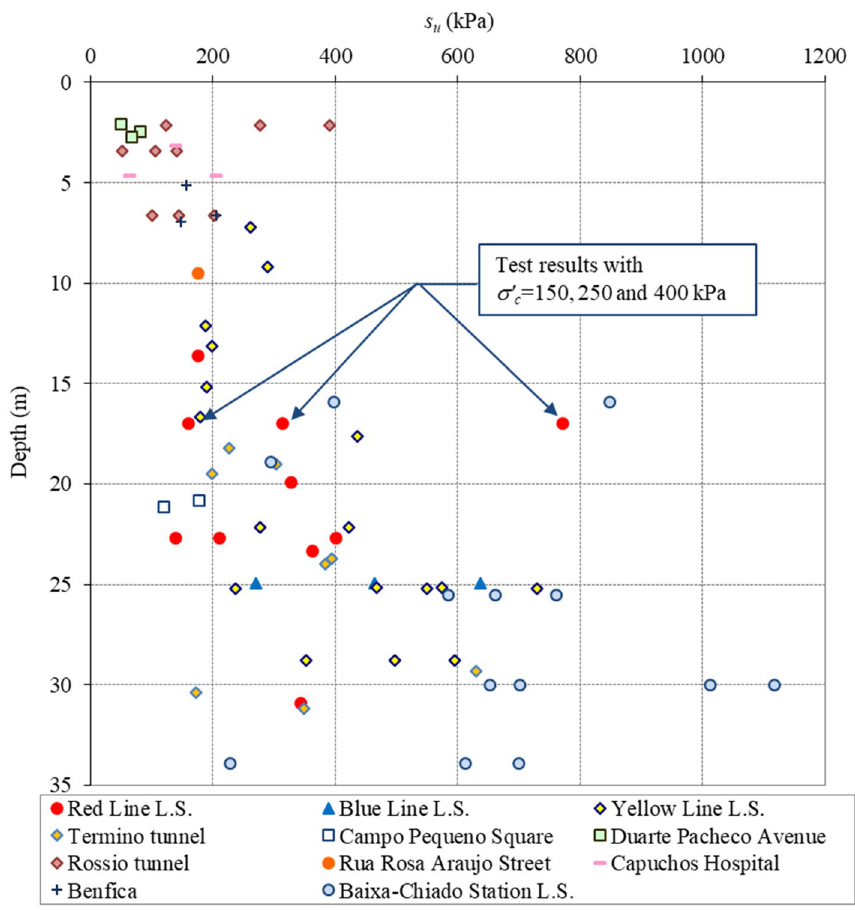
Fig. 5 Undrained shear strength in depth for the entire set of results of triaxial com‑ pression